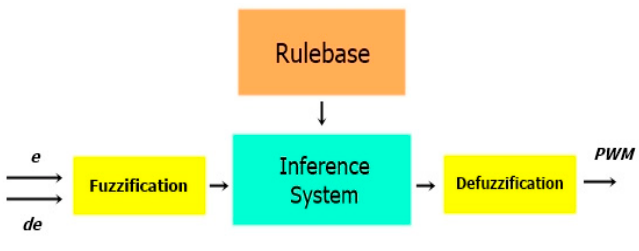
Figure 4. Structure of fuzzy logic controller.